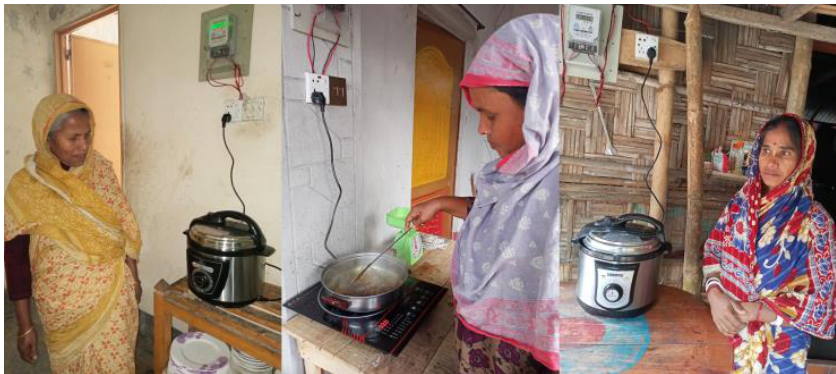
Figure 2. Respondents using electric cooking appliances (Anisa, Raisa and Sheuli from left to right).